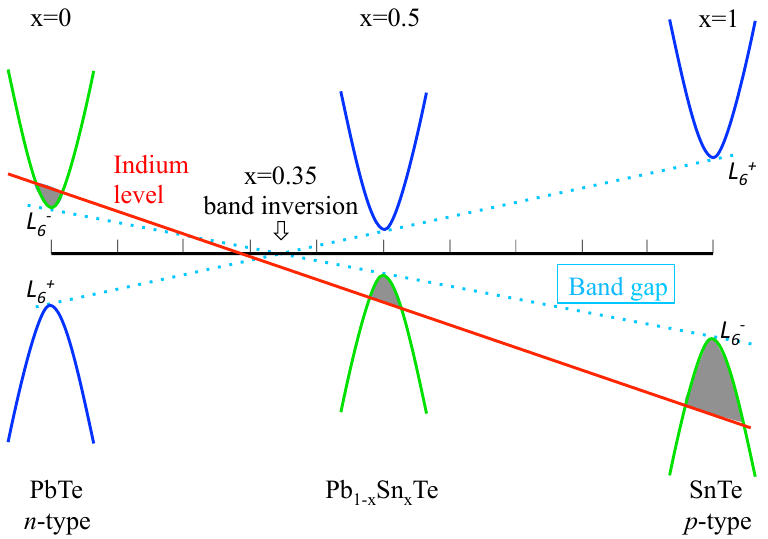
Figure 5. Energy diagrams illustrating the relative location of the conduction, valence band, and indium-induced impurity band in the continuous series of Pb 1 − x Sn x Te alloys with low In doping level, where indium can be simply treated as a p -type dopant. In SnTe, the conduction band has a symmetry of L + ; this undergoes a band inversion at x ∼ 0.35, and the symmetry is inverted in PbTe. The band 6 gap is illustrated with blue dashed lines, with the end member SnTe having 360 meV and PbTe having 190 meV [59]. The Fermi level—controlled by the indium impurity states—is indicated schematically by the red